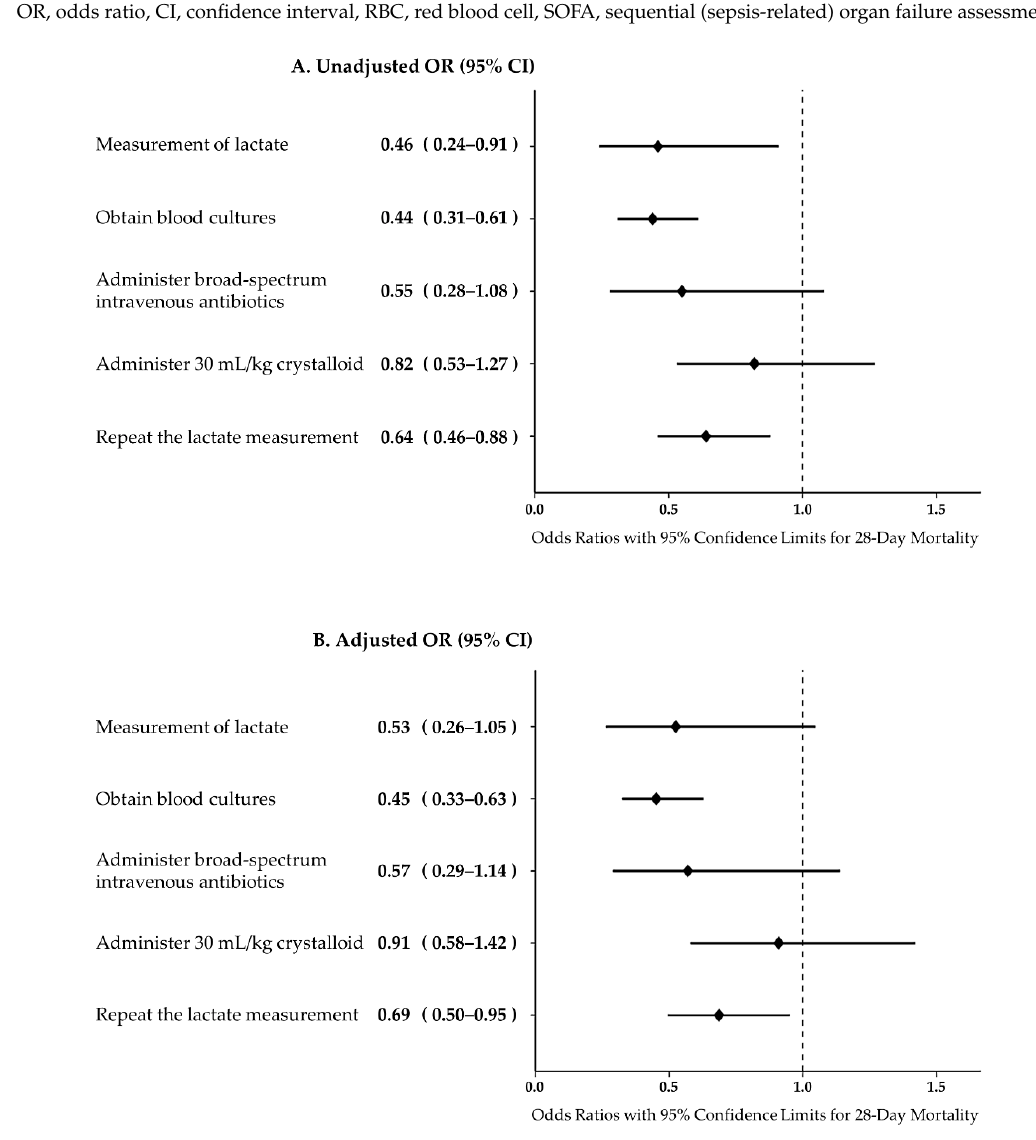
Figure 3. Multiple multivariate logistic regression model for bundle components with 28-day mortality in septic shock patients; OR, odds ratio, CI, confidence interval.